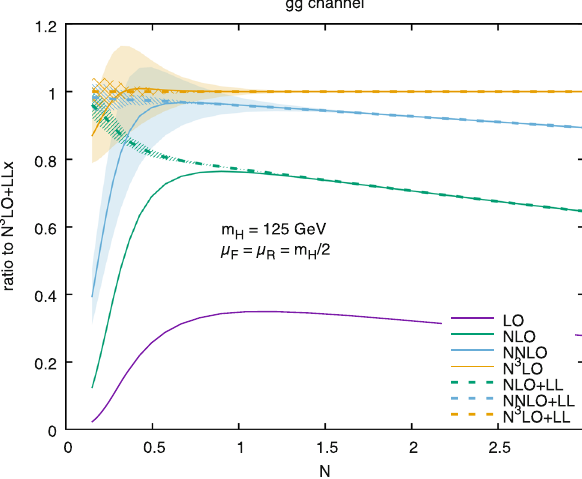
= 0 and symmetrizing the variation; the band at N 3 LO is just A ( k ) 0 the one from the O (α 3 s ) contribution and does not contain the contri- bution from the previous order. Similarly, the uncertainty bands on the resummed contributions (right plot only) are estimated as the difference between the NLL and LL (cid:2) variants of the resummation. The scales are μ = μ = m / H F R